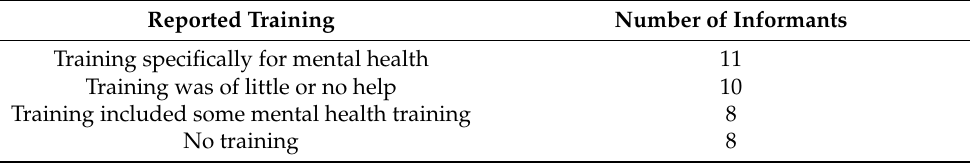
Table 3. Reported informant training and perceived usefulness of training in mental